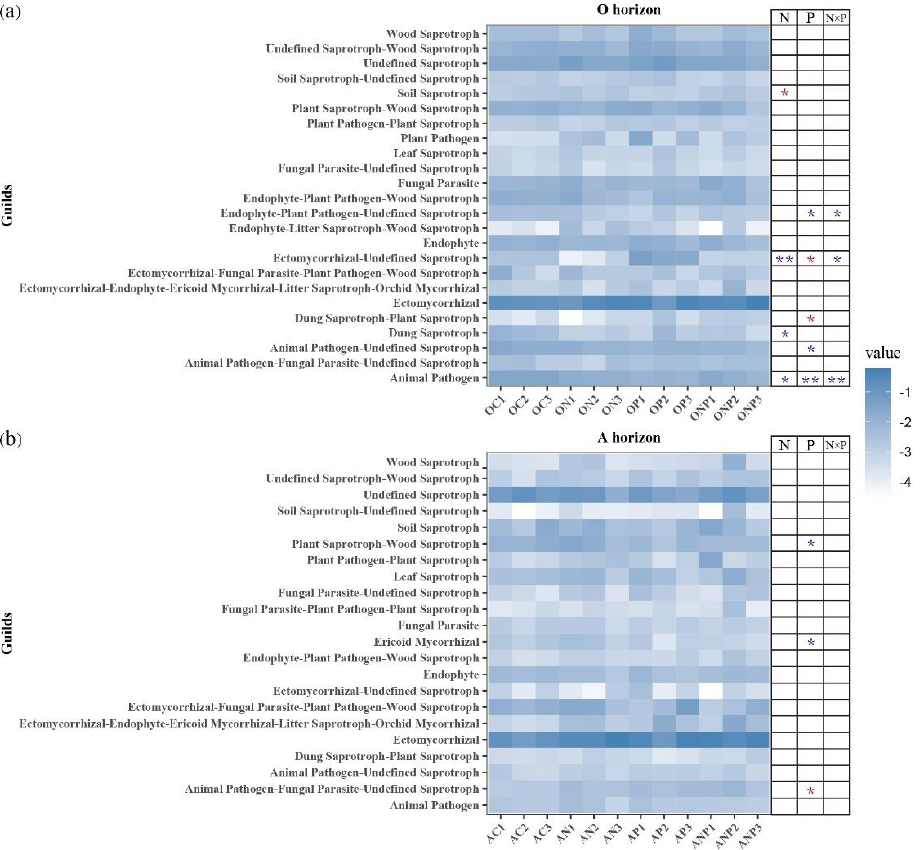
Figure 6. The relative abundance of putative fungal functional guilds under N and P additions based on the FUNGuild database. N, P and N × P showed the effects of N, P and NP interaction on bacterial and fungal diversities, respectively (two-way ANOVA, * p < 0.05, ** p < 0.01). Red asterisks indicate positive effects and blue asterisks indicate negative effects. OC, ON, OP and ONP indicate the O horizon soils (0–5 cm, ( a )) under control (C, without N and P addition), N addition, P addition and NP addition, respectively. AC, AN, AP and ANP indicate the A horizon soils (5–15 cm, ( b )) under control (C, without N and P addition), N addition, P addition and NP addition, respectively.